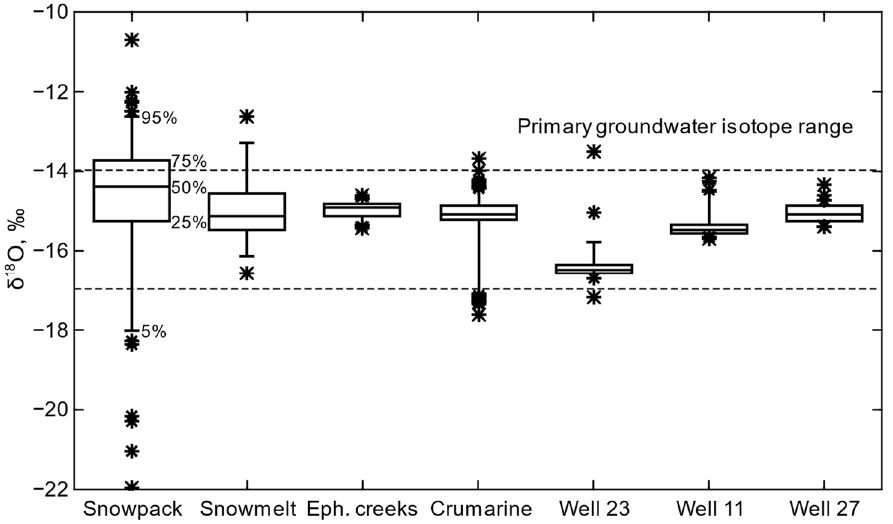
Figure 14. Boxplots of δ 18 O values for snow, snowmelt, surface water, and groundwater in the South Fork Palouse River Basin. The three included wells contain groundwater with δ 18 O values that are relatively depleted, mixed, and enriched compared to all groundwater samples collected throughout the recharge zone (Figure 11). Snowpack, snowmelt, ephemeral creek sampling were weighted towards spring-time sampling (enrichment period).